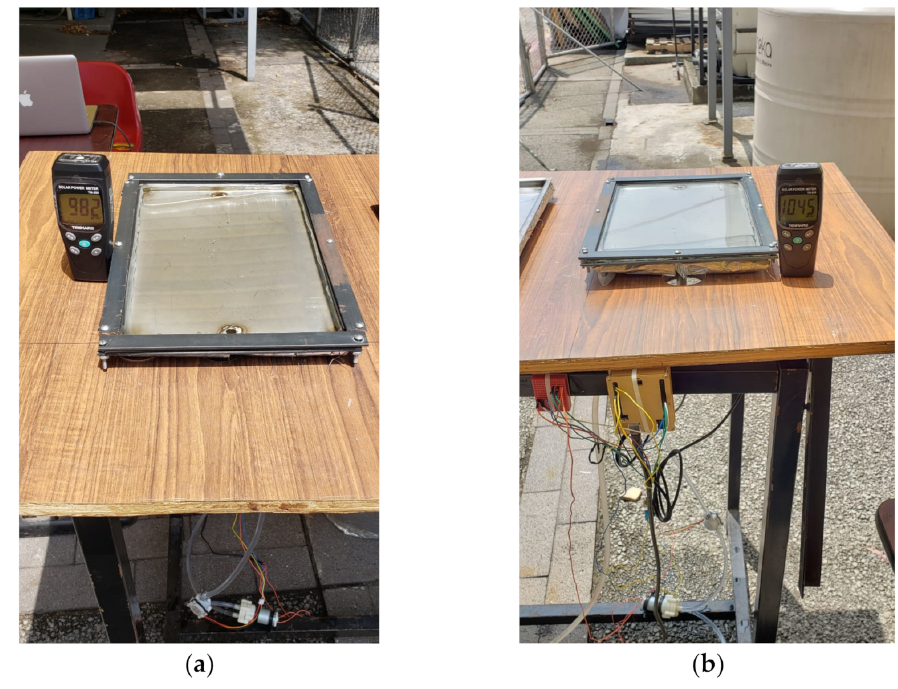
Figure 11. Direct Absorption Solar Collector used in the experimental tests, ( a ) front view, ( b ) back